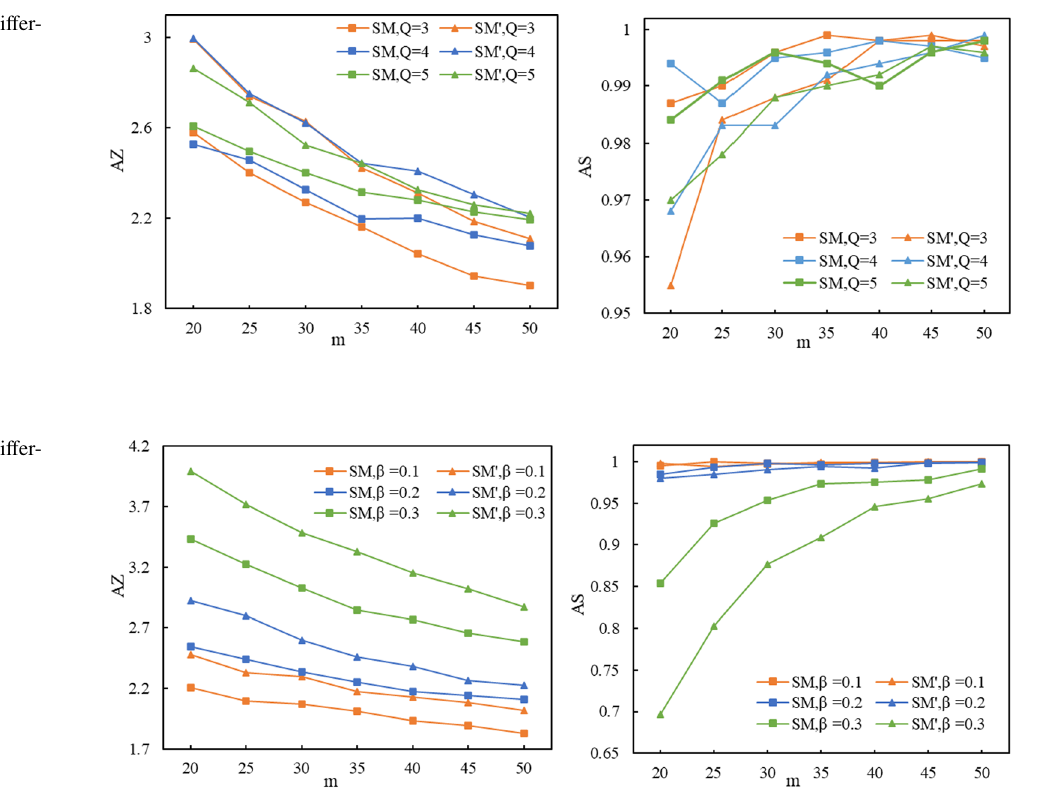
Fig. 3 AZ and AS under differ- ent parameters m and